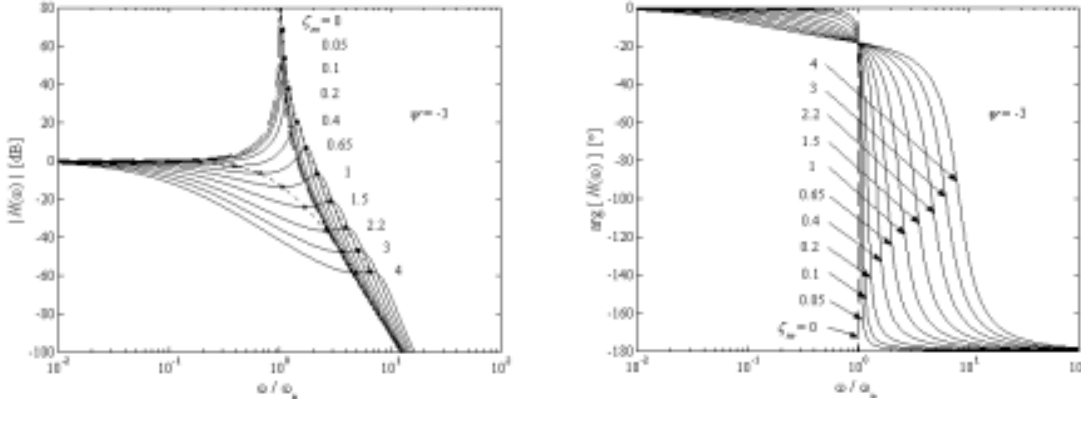
Fig. 10. Modulus (left) and phase (right) of FRF for ψ = − 3 .